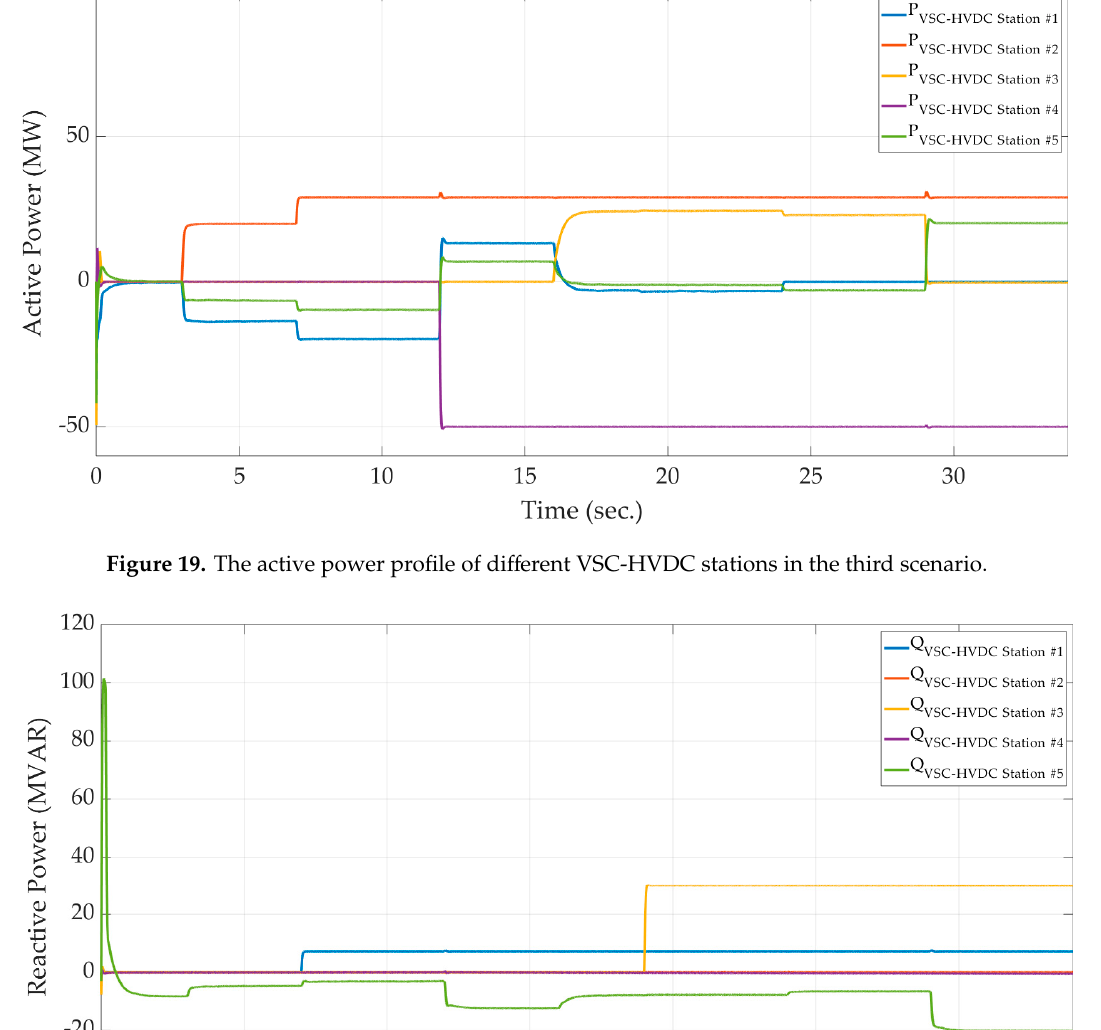
Figure 18. The AC voltage profile of different VSC-HVDC stations in the third scenario.